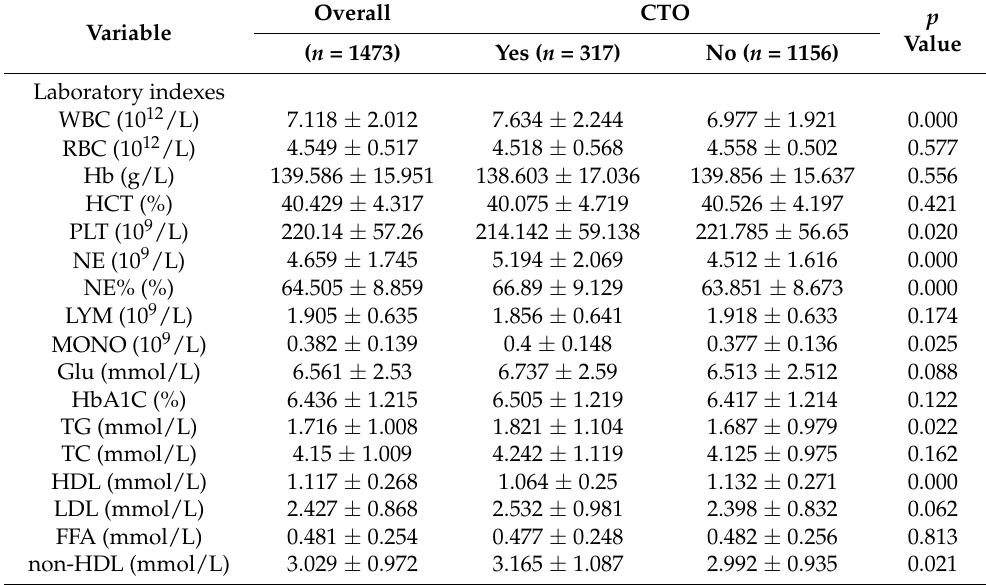
Table 2. Baseline laboratory indexes of study